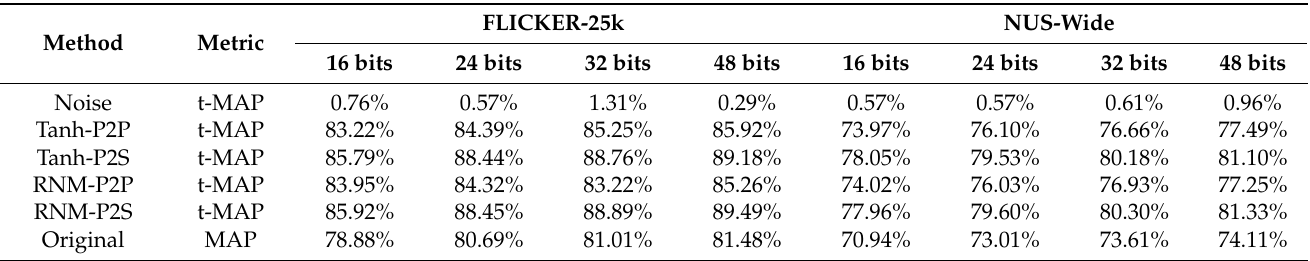
Table 1. t-MAP(%) on targeted attack methods and MAP(%) of query object with the target hash code of query images under 16, 24, 32, 48 bits hash code on two images datasets.